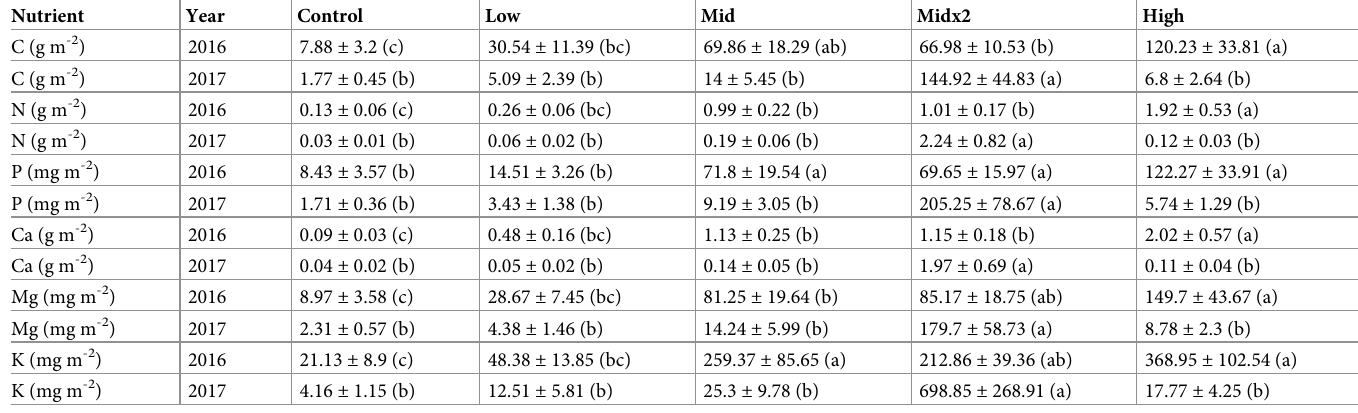
Letters signify differences among treatments within a sampling period using P <